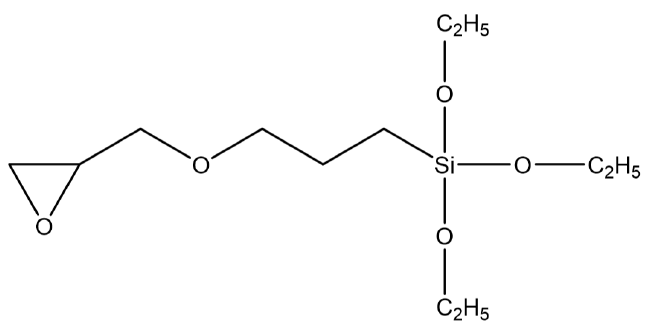
Figure 2. Structural formula of KH560.